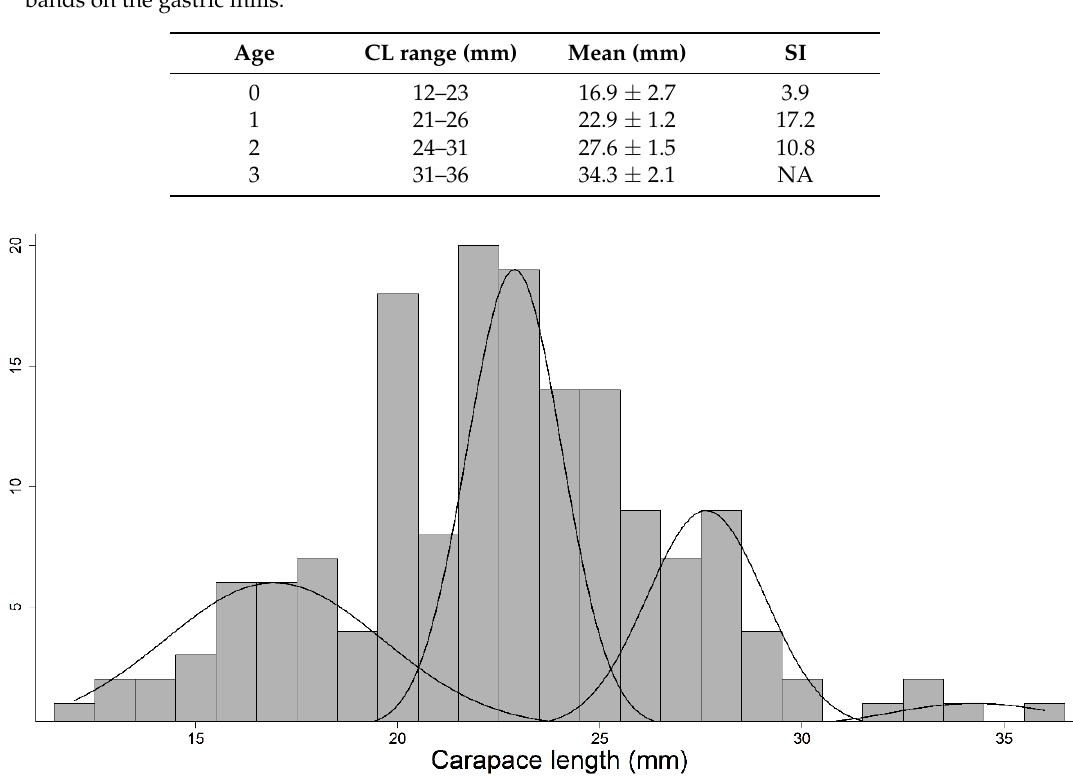
Table 1. The carapace length (CL) range, mean (± standard deviation), and separation index (SI) of age classes are reported for gapped ringed crayfish Faxonius neglectus chaenodactylus sampled from Big Creek near the confluence of Tumbling Creek. The separation index describes the degree of separation between age classes (i.e., a SI of < 2 describes a cohort that cannot be distinguished from other cohorts). Data were generated using the Bhattacharya method and compared to age estimates from counting bands on the gastric mills. Age CL range (mm) Mean (mm) SI 0